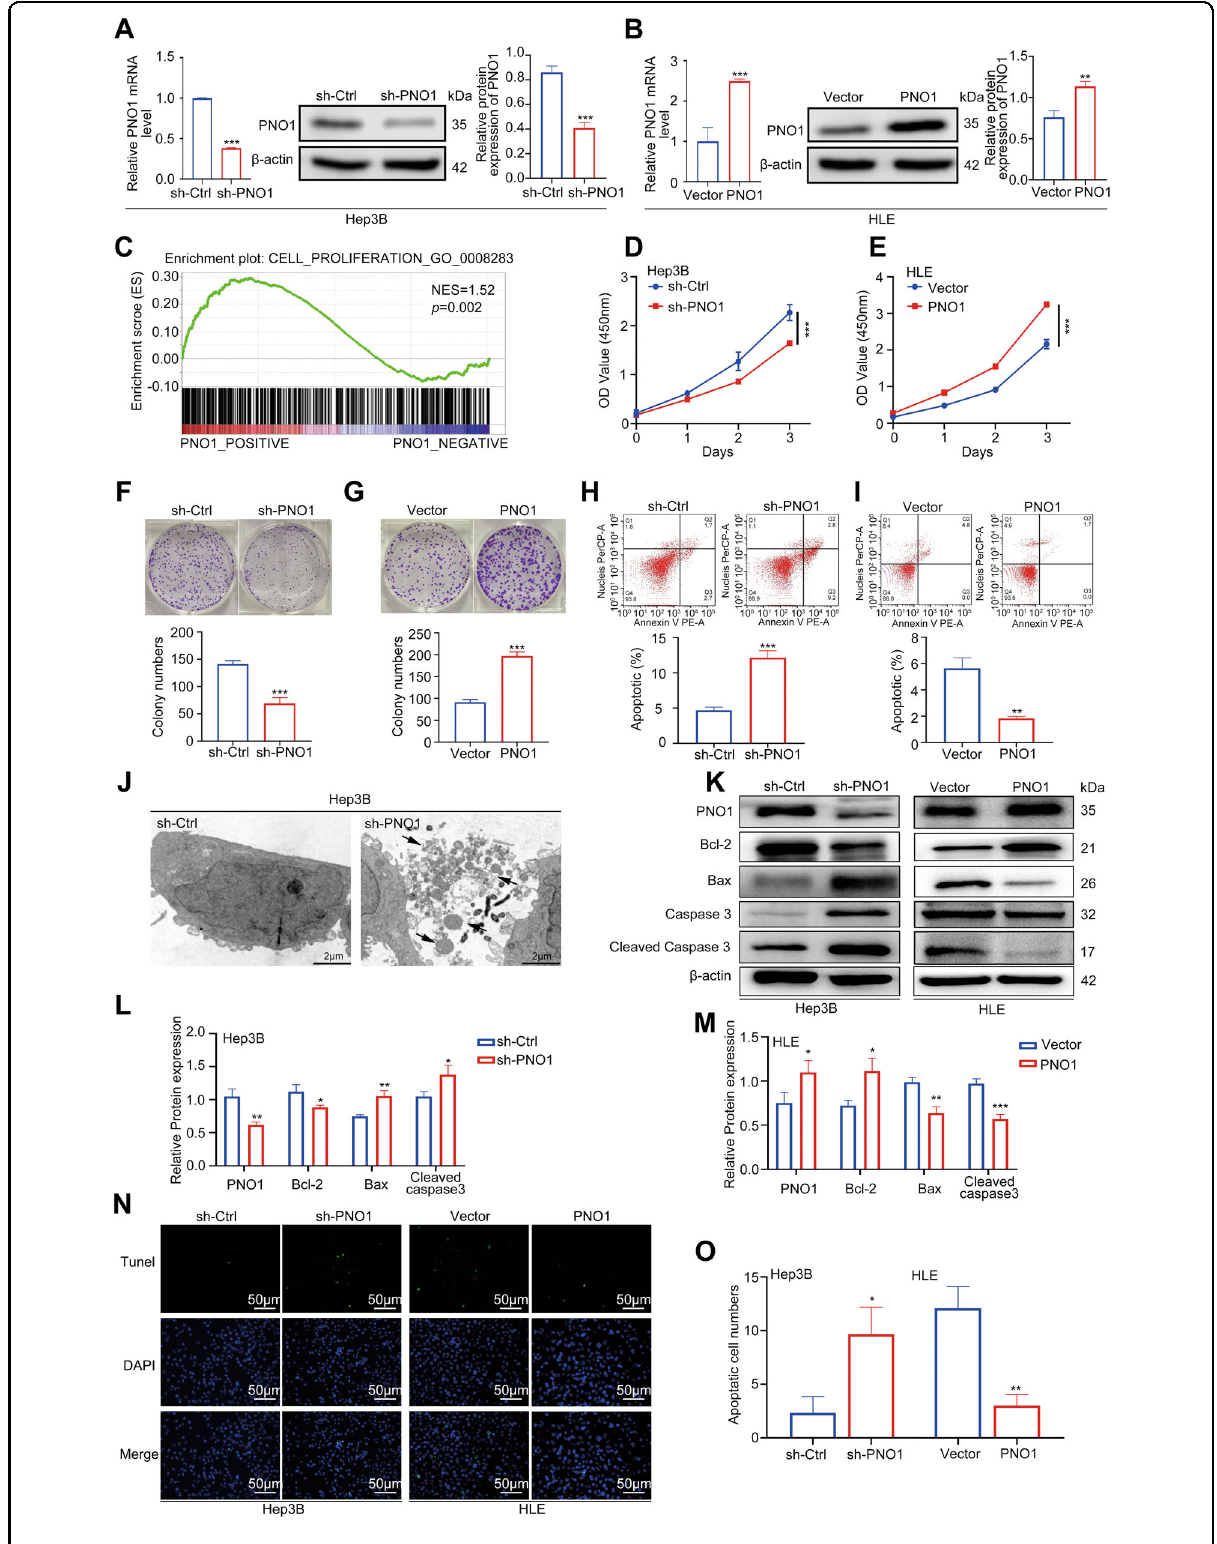
Fig. 2 (See legend on next